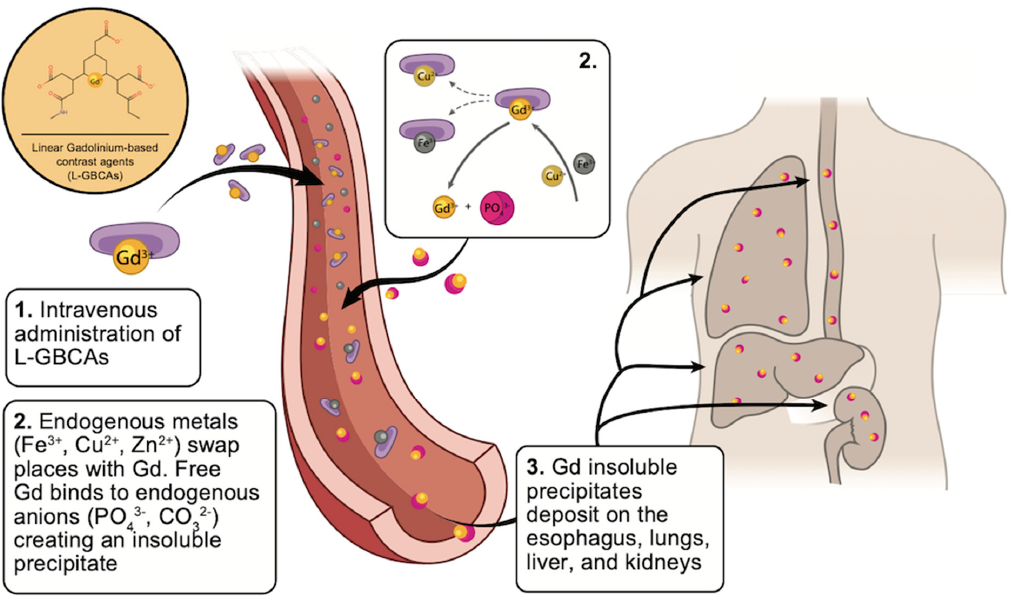
Figure 2. NSF pathophysiology: transmetalation and deposition of gadolinium-based contrast agents.